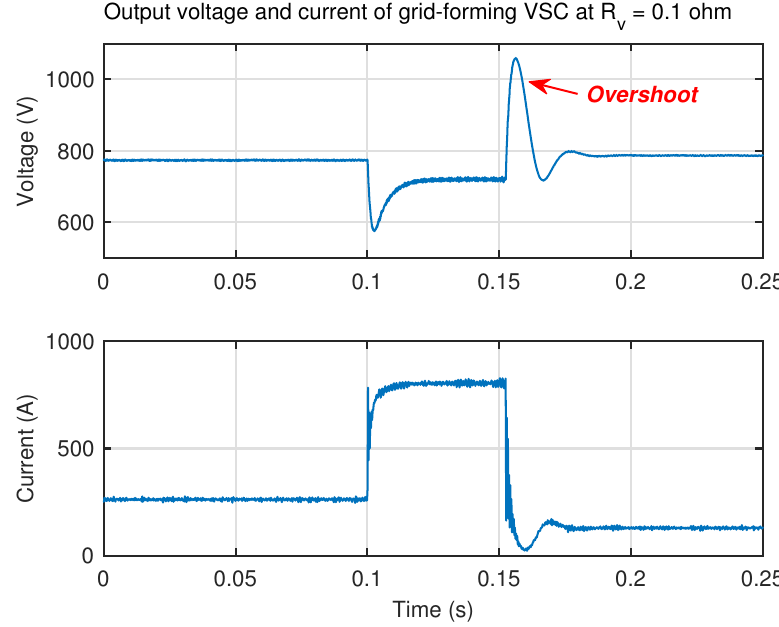
Figure 12. Output voltage and output current of grid-forming VSC when R v is 0.1 Ω